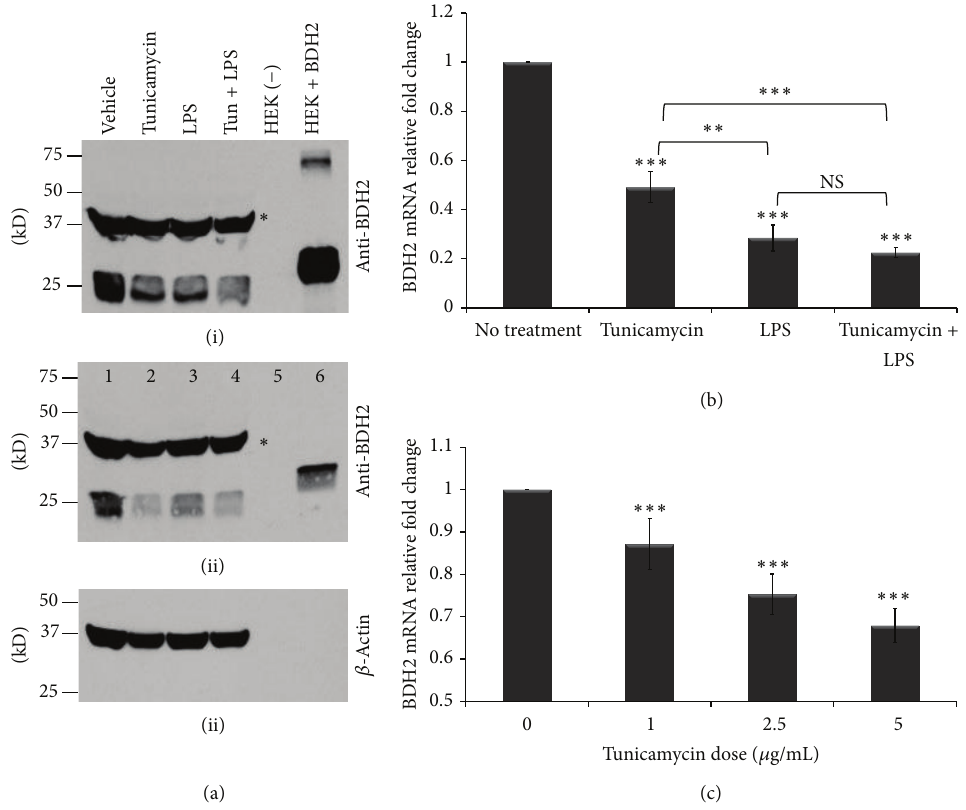
Figure 1: ER stress and inflammation downregulate BDH2 expression in macrophages. (a) Western blot analysis of BDH2 protein expression in THP-1 macrophage-like cells ( 1 × 10 6 cells/mL) treated with tunicamycin (10 𝜇 g/mL) or vehicle (DMSO) overnight prior to LPS exposure (40ng/mL) for 6 hr. BDH2 protein was detected with monoclonal anti-BDH2 TrueMAB antibody clone 2G. Lane 1: vehicle-treated THP-1 cells; 2: tunicamycin treated; 3: LPS treated; 4: tunicamycin and LPS treated; 5: untransfected HEK293 cells as negative control; 6: BDH2 transfected HEK293 cells as positive control (BDH2 positive control contains a FLAG tag and 10-fold higher concentration was loaded in panel (i) compared to panel (ii), representing two independent experiments); ∗ nonspecific band. (b) THP-1 macrophages were treated with tunicamycin (10 𝜇 g/mL) as above and RNA was extracted and BDH2 gene expression was assessed by quantitative RT-PCR normalized to that of 𝛽 -actin.(c)THP-1cellstreatedwithtunicamycindoses1,2.5,or5 𝜇 g/mLandincubatedovernight.ThefoldchangeinBDH2geneexpression was calculated in reference to DMSO treated control THP-1 cells using the ΔΔ CT method and presented here normalized to vehicle (DMSO) treatment control. Error bars represent the SD from the mean of nine readouts generated from three independent experiments. ∗ 𝑃 values were calculated in reference to vehicle (DMSO) treatment control using one-way ANOVA followed by Bonferroni multiple comparisons post hoc analysis. 𝑃 values annotated ∗∗∗ 𝑃 < 0.0001 ; ∗∗ 𝑃 = 0.001 – 0.01 ; 𝑃 > 0.05 were not significant (NS).